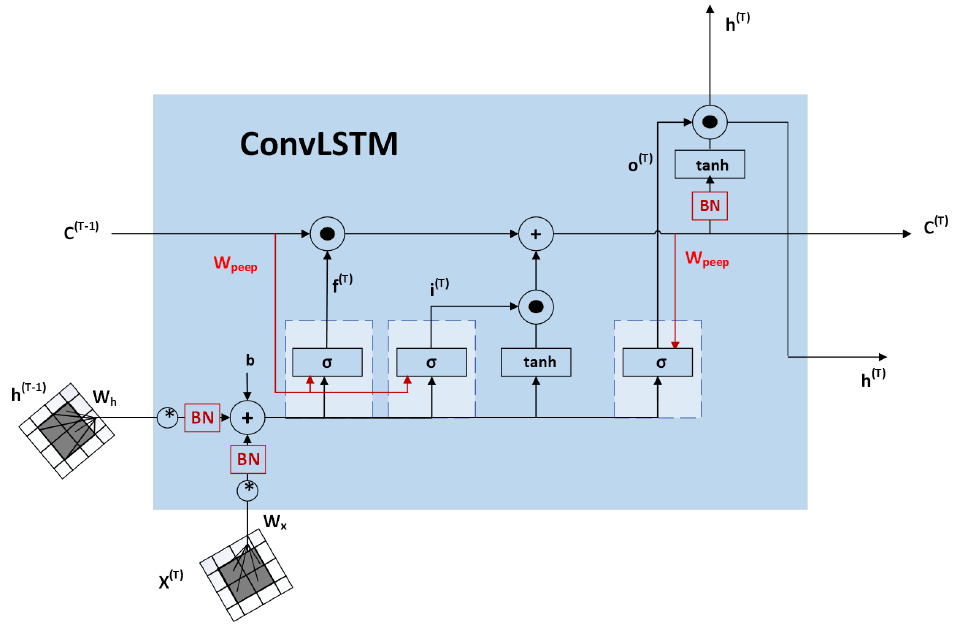
Figure 1. Structure of ConvLSTM